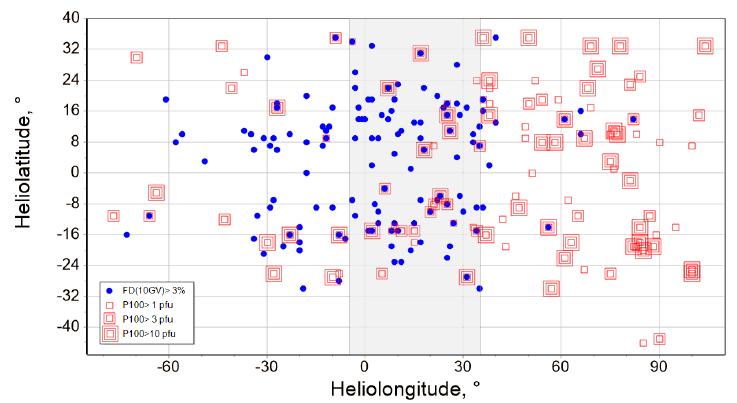
Figure 2. Distribution of longitudes of solar sources associated with large FDs ( A F > 3%) and SEPs (for particles with energies E > 100 MeV) with different peak